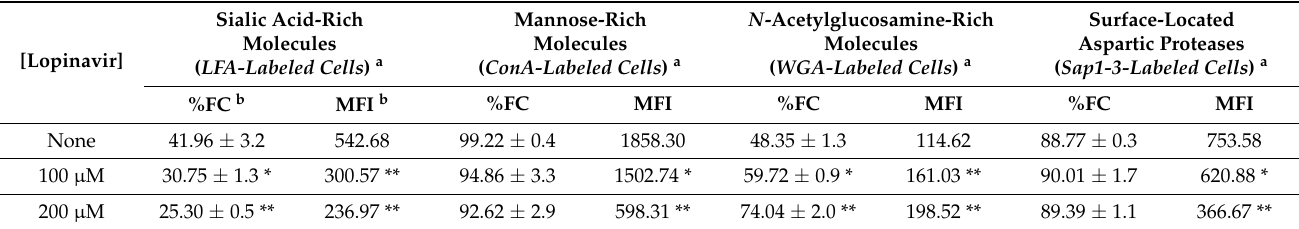
Table 2. Effects of lopinavir on the expression of cell surface molecules in C. albicans .